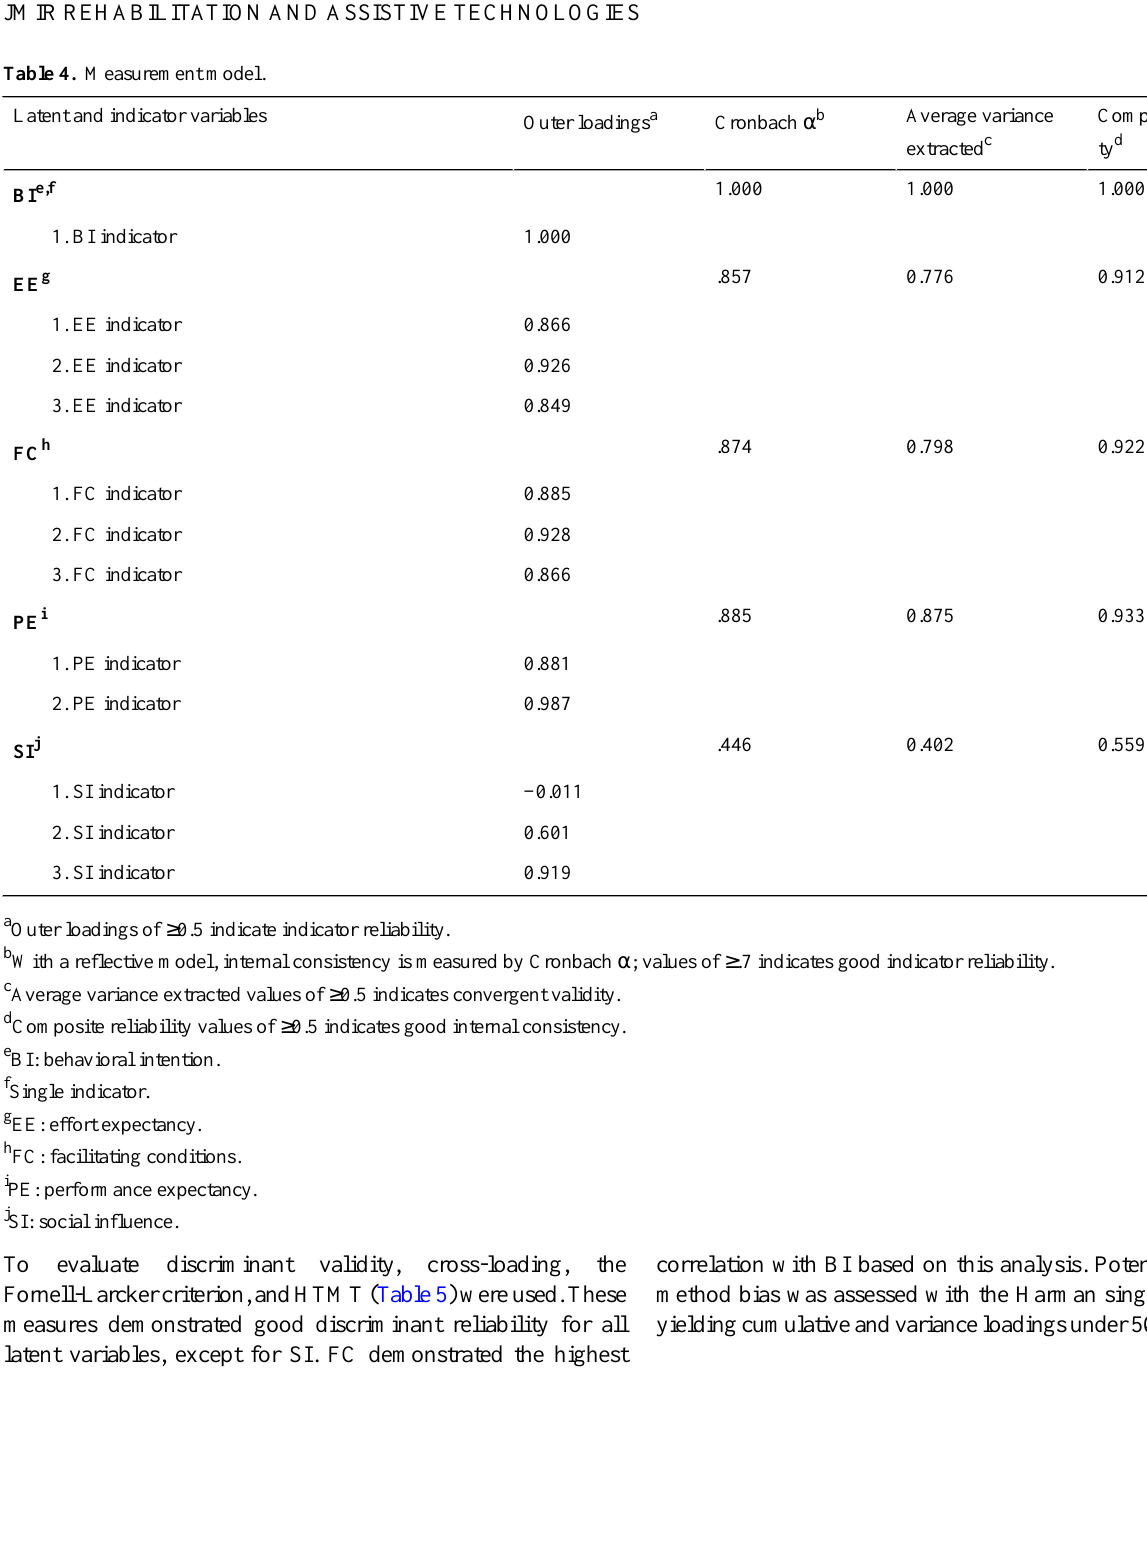
Table 4. Measurement model.